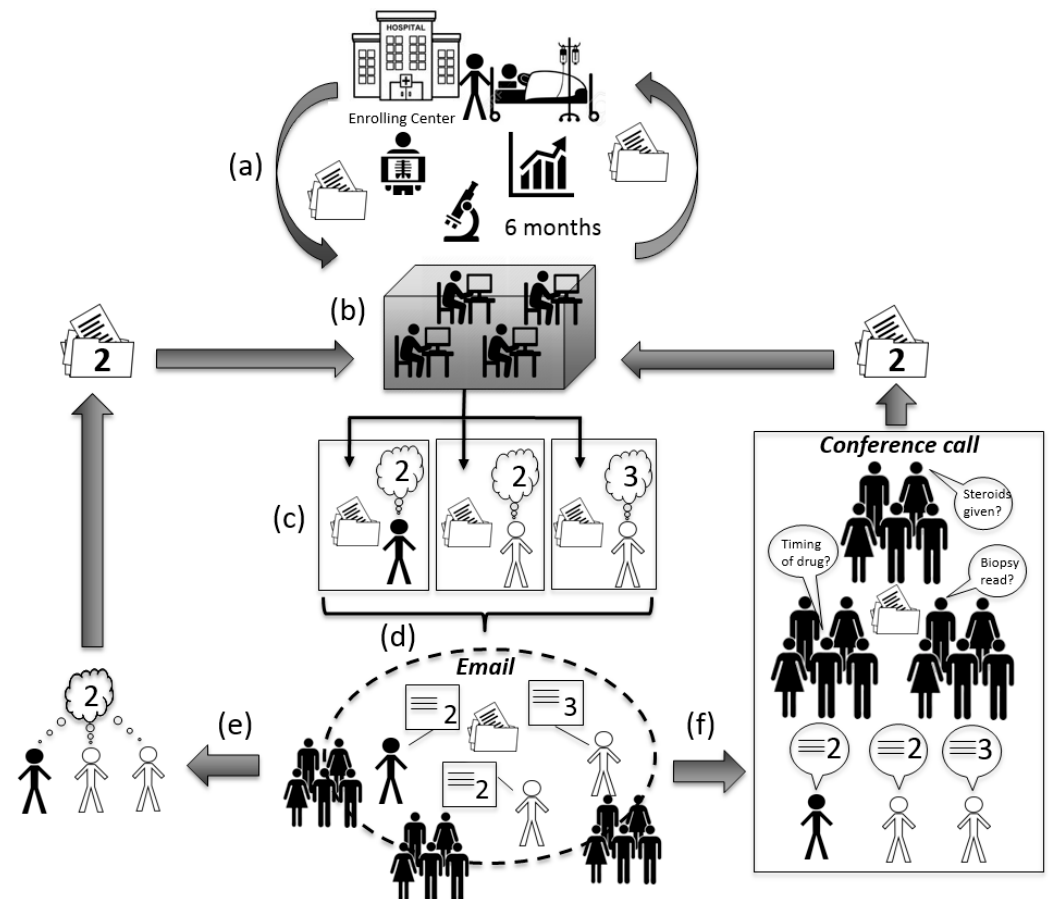
Figure 2. Drug-Induced Liver Injury Network (DILIN) consensus causality assessment. ( a ) Six months of clinical information are collected at the enrolling center and communicated to the data coordination center. Clinical narrative created and approved by enrolling center; ( b ) Narrative and data forms created by the coordinating center; ( c ) Finalized narrative and data forms uploaded to a secure website for the enrolling investigator and two other DILIN hepatologists, chosen at random, to independently review. Reviewers are given two to three weeks to render a causality score on the website. In this example, two reviewers give the case a “2”, but one reviewer renders a “3”; ( d ) Scores are released to the group and email communication between the three reviewers occurs over four days to resolve differences in scoring. All DILIN hepatologists have the opportunity to comment on the case at this stage; ( e ) If consensus amongst the three reviewers is obtained by email, then finalized score is sent back to the data coordinating center to be logged; ( f ) If consensus is not obtained via email, then the case is formally presented and discussed with all DILIN hepatologists by conference call. All attendees have the opportunity to ask questions, make comments and give opinions. If agreement amongst the three reviewers is still not reached, then consensus is obtained by majority vote (one vote per center). Finalized score sent back to the data coordinating center to be